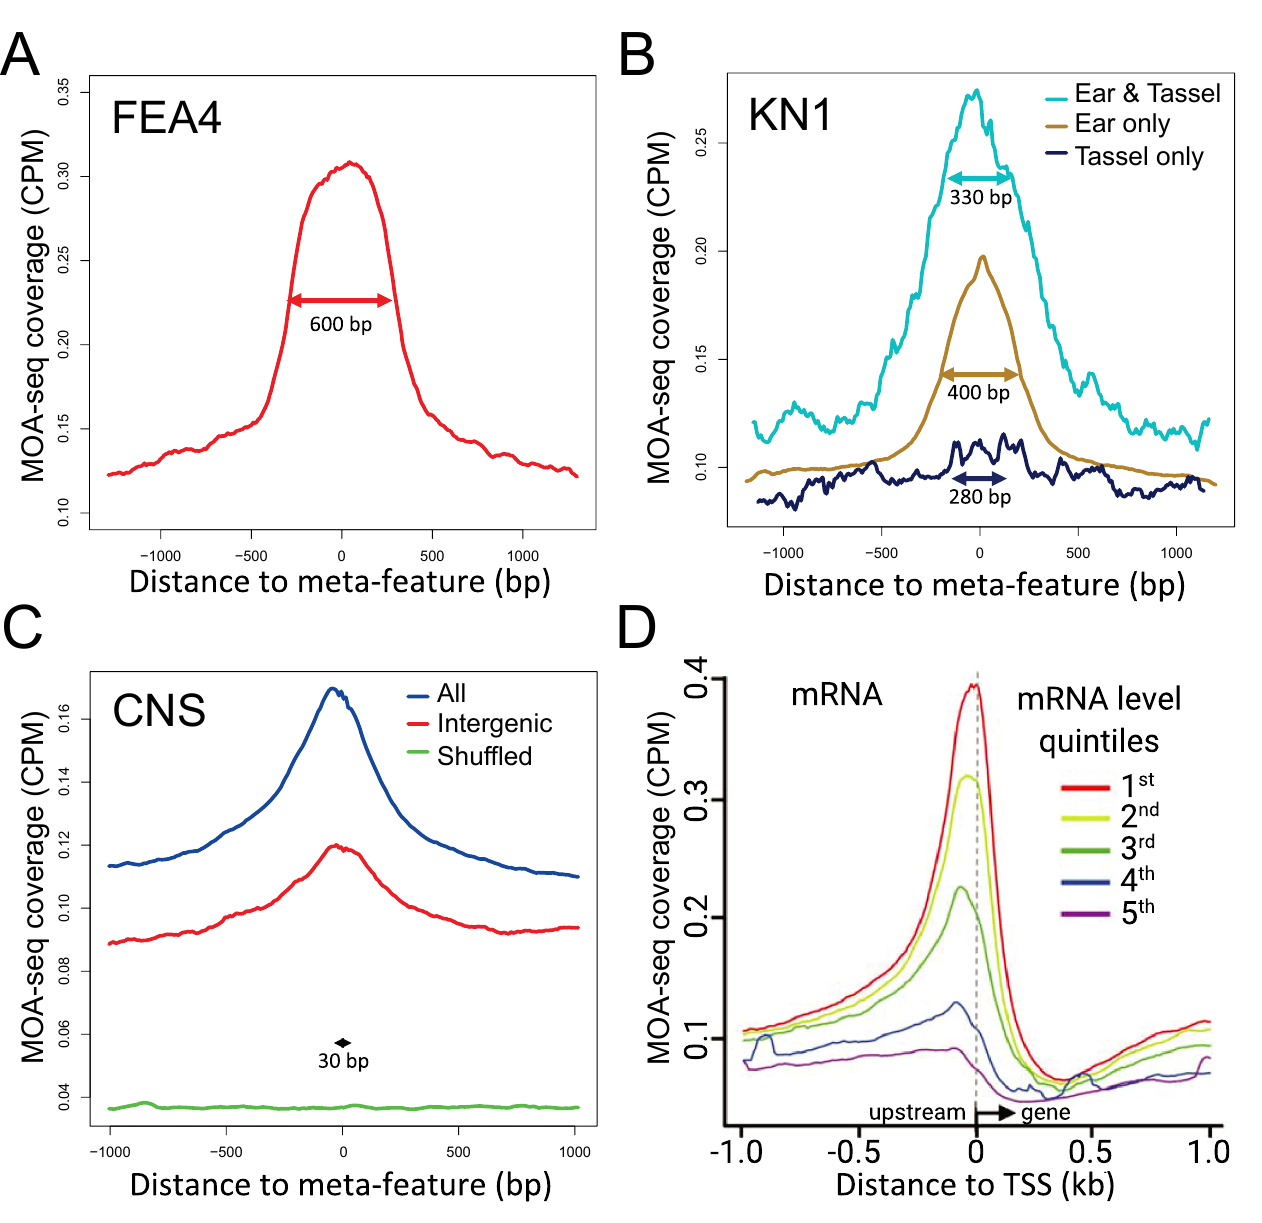
Fig 4. MOA-seq overlaps with TF-binding sites and correlates at promoters with mRNA levels. Average earshoot MOA-seq coverage was plotted around the midpoints for FEA4 tassel ChIP-seq peaks (A), Knotted1 ChIP-seq peaks subdivided into Ear only, Ear & Tassel, or Tassel only (B), and conserved non-coding sequences (CNS) showing all, position-shuffled control (Shuffled), or an intergenic subset classified as being more than 1 kb from genes (C). For each plot, the average peak size was used to define a single metapeak size (metapeak, indicated in each plot) for fitting the data within the peak region; metapeak flanking regions are in real bp relative to the metapeak region. (D) MOA-seq coverage is positively correlated with gene regulation. Mean MOA-seq coverage for genes divided into quintiles (1 st highest mRNA to 5 th lowest mRNA level) according to mRNA levels in earshot